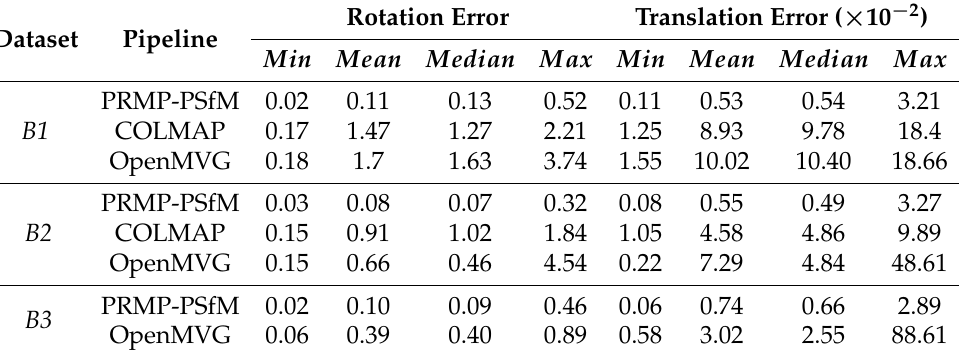
Figure 15. Reconstruction results of three benchmark datasets from different SfM pipelines. Table 3. Quantitative evaluation for benchmark datasets B1 , B2 and B3 . Rotation error is the angular difference from the reference, in degrees; translation error is the position difference from the reference in ground-truth